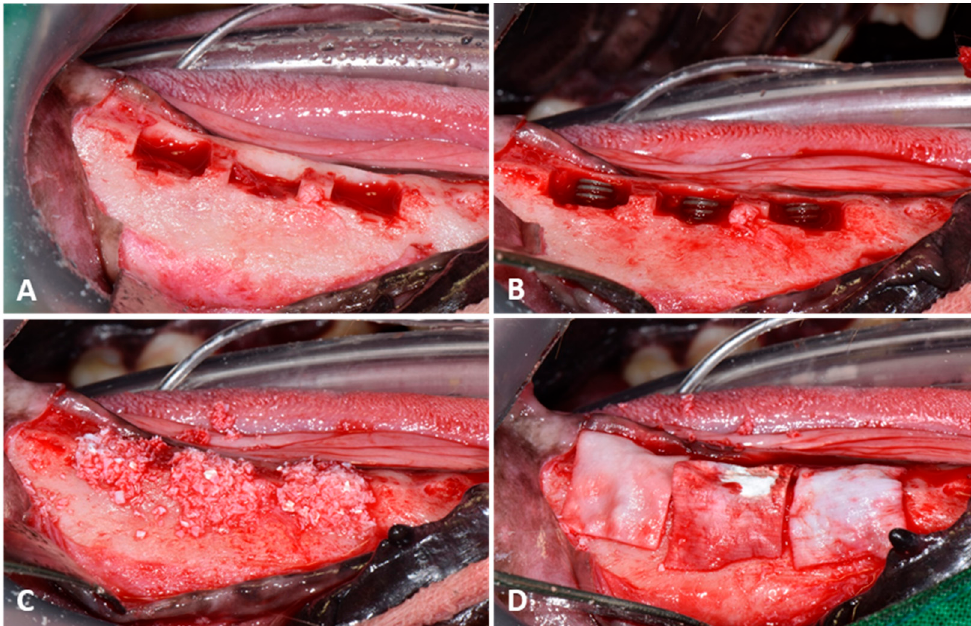
Figure 1. Surgical procedures used to place surface-treated implants in beagle mandibles. ( A ) Creation of buccal cubic defects, ( B ) Implant placement, ( C ) Distribution of bone graft material, ( D ) Collagen membrane placement.